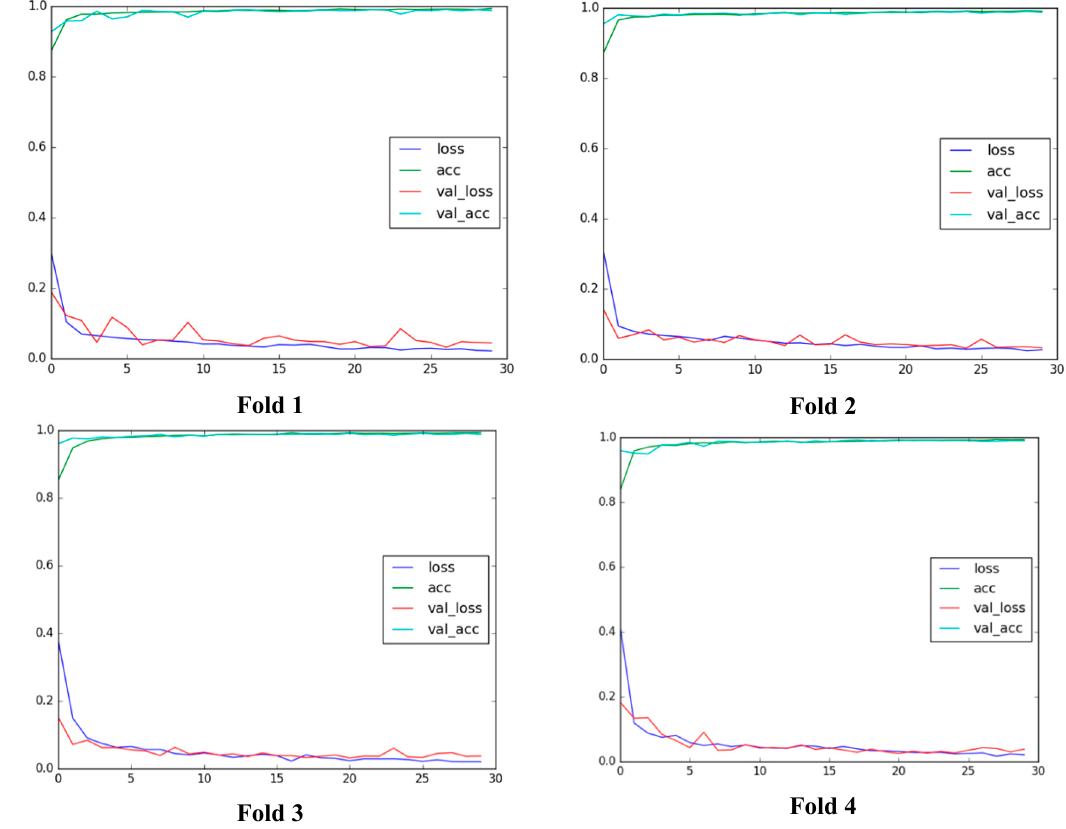
Figure 7. Generated images from the trained PCGAN model.